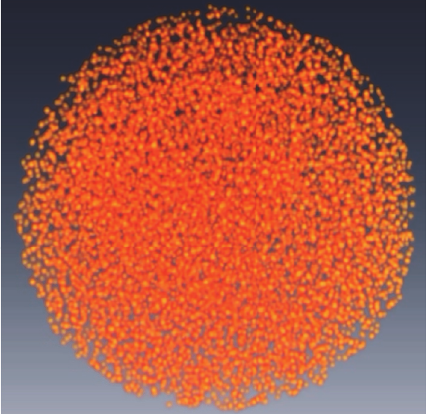
Figure 8: Adjustable 3D visualization of particles in a pebble.